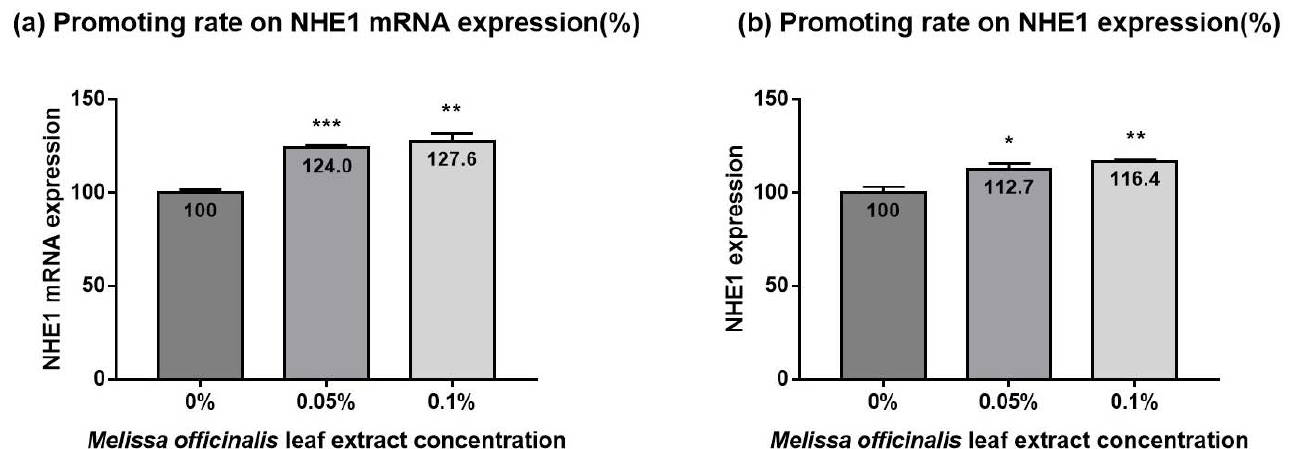
Figure 1. Promoting effects of Melissa officinalis leaf extract on NHE1 expression. M. officinalis leaf extract ‐ containing solution increased expression levels of NHE1 mRNA ( a ) and NHE1 ( b ), compared to the control. Data are presented as the mean ± SD ( n = 3). NHE1, sodium proton exchanger 1. Student’s t ‐ test p ‐ values indicate statistical significance (* p < 0.05, ** p < 0.01, and *** p < 0.001).